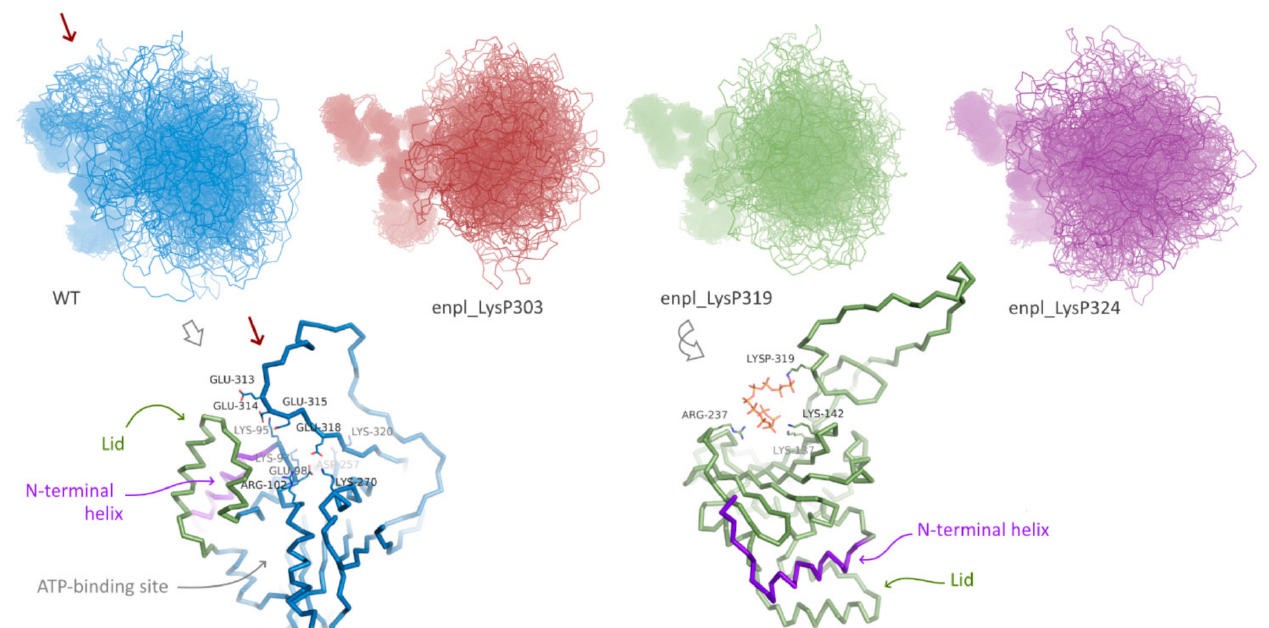
Figure 4. Conformation ensembles obtained using REMD simulations N-terminal domain of native endoplasmin and three polyphosphorylated forms: LysP303, LysP319, and LysP324. Red arrow indicates additional interaction of the disordered charged linker with globular part of N-terminal domain in native endoplasmin; example of such interaction is presented in